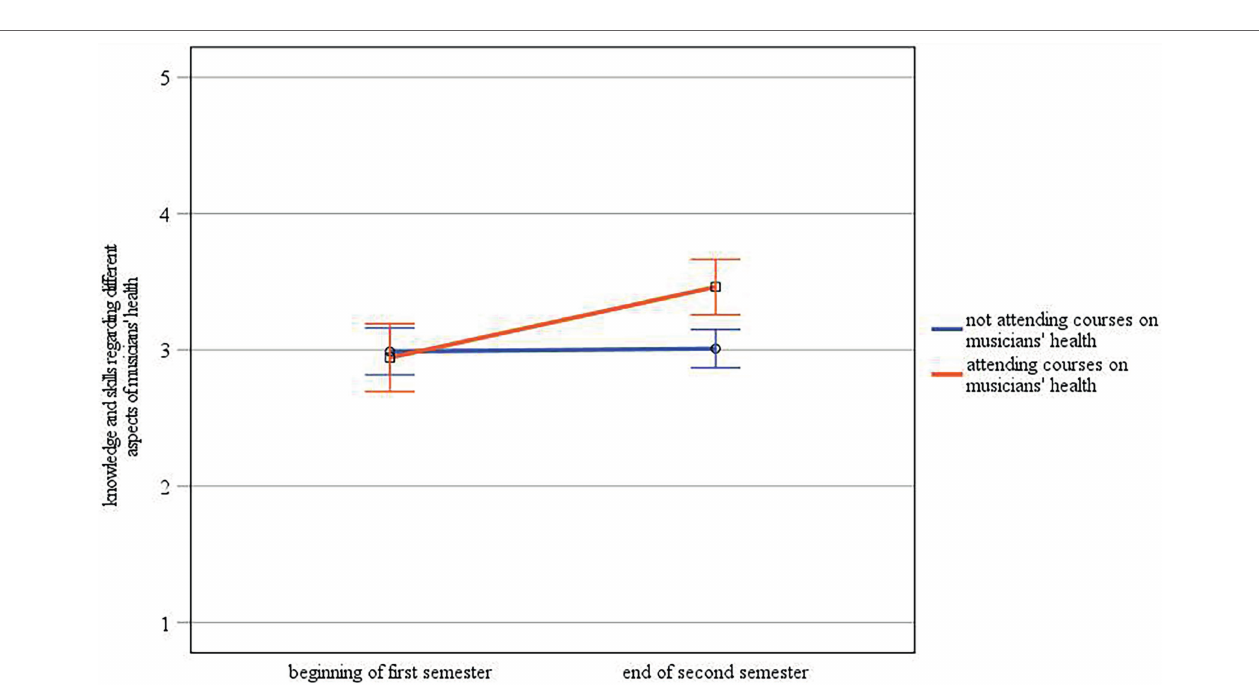
first semester ( M = 2.94), but not for the group who did not attend such courses [ F (1.41) = 0.06, p = 0.80, η p 2 = 0.00; M beginning first semester = 2.99, M end second semester =